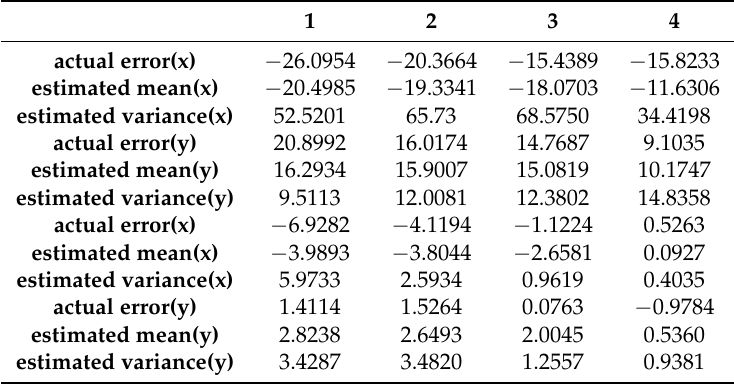
Table 3. Actual measurement error and estimated statistical